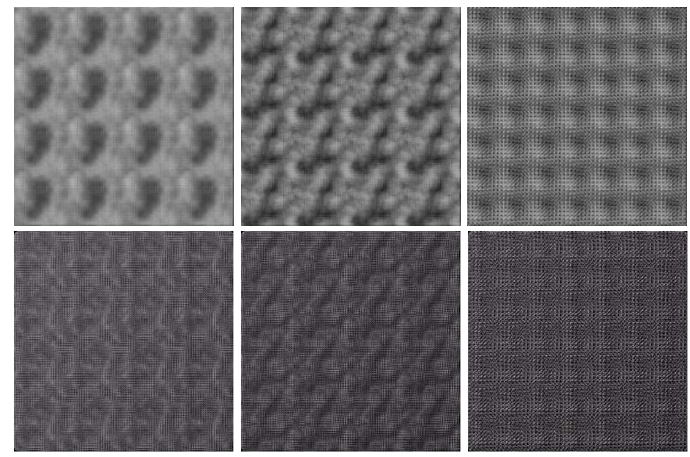
Figure 6. Matrix transformation textures. First, row: height maps. Second row: relighting